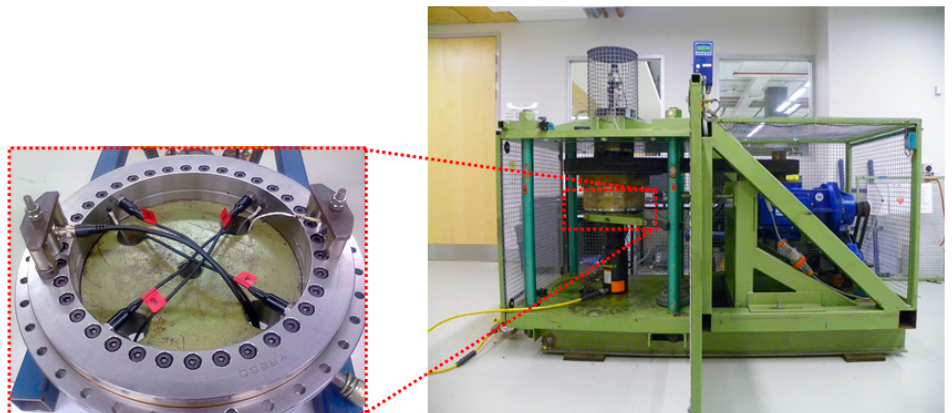
Figure 1. Photo of slew bearing lab test rig and sensor location.